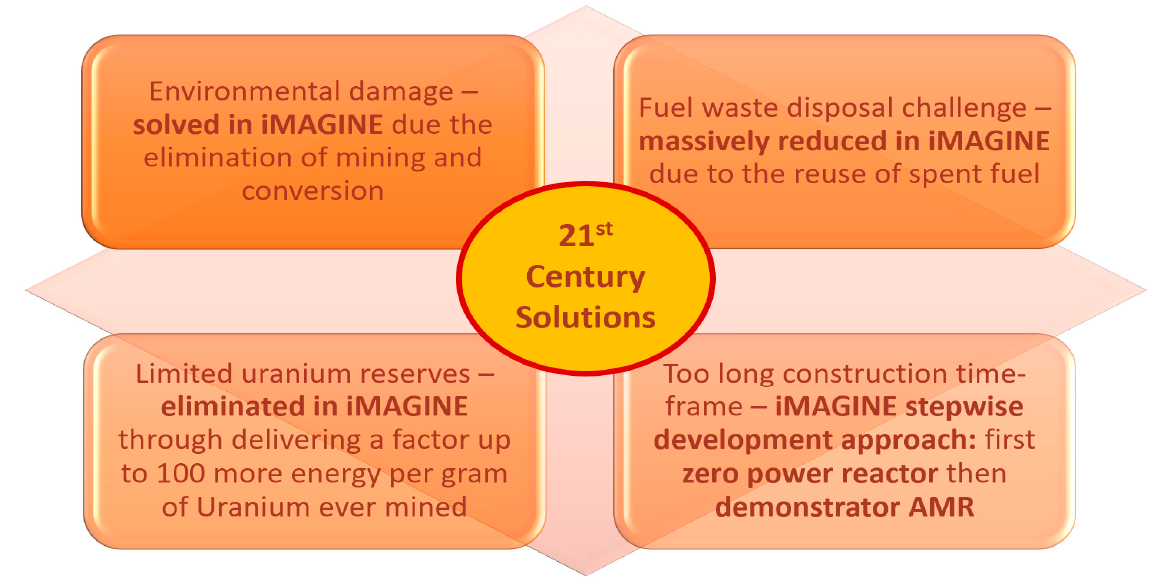
Figure 10. Overview of the solutions offered by iMAGINE to resolve the challenges of the 21st century in the view of the public as well as in the scientific and business community.